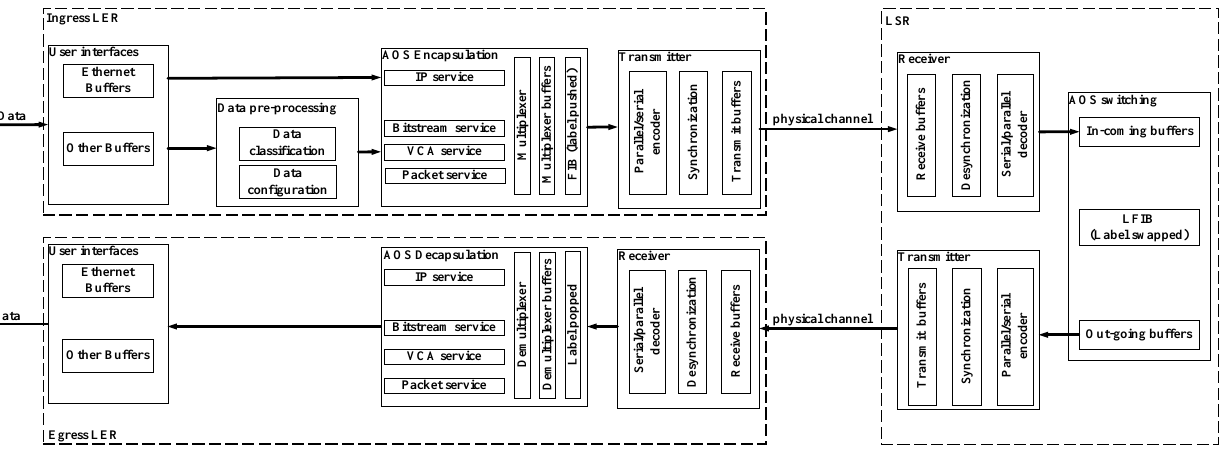
Figure 7. The functional block diagram of four types of service over AOS